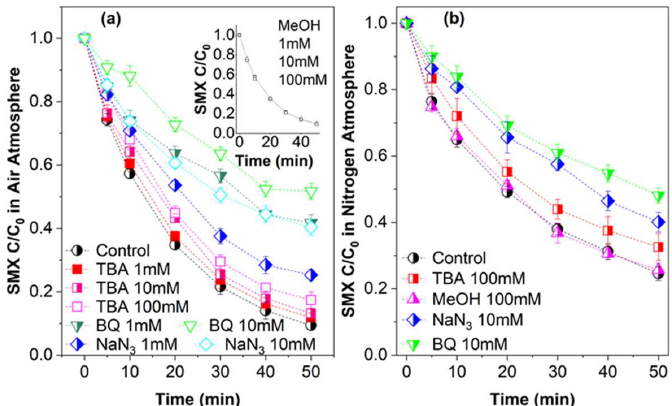
Figure 3. Chemical quenching in SMX degradation by CuO@CNT/PDS ( a ) in air; ( b ) in nitrogen. Conditions: SMX = 39.5 µM, PDS = 1.0 mM, Activator = 0.1 g/L, pH = 5.6 ± 0.1.